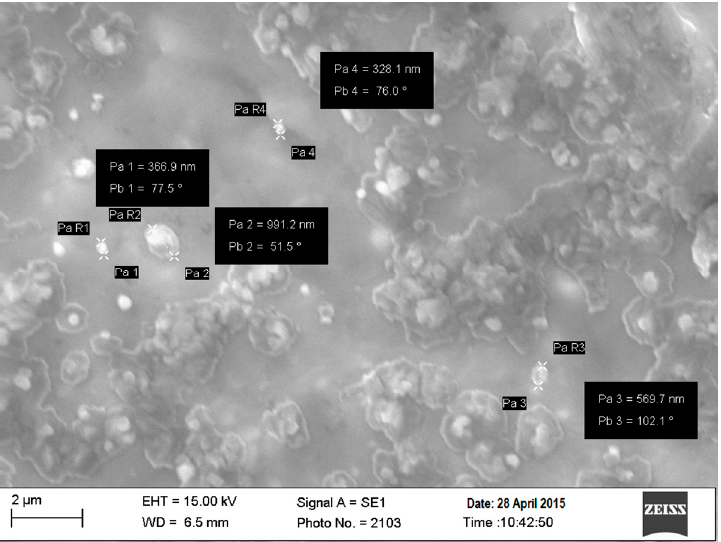
Figure 11. A SEM image of BB aerosol from the smoldering stage of white pine combustion during open fire burn.